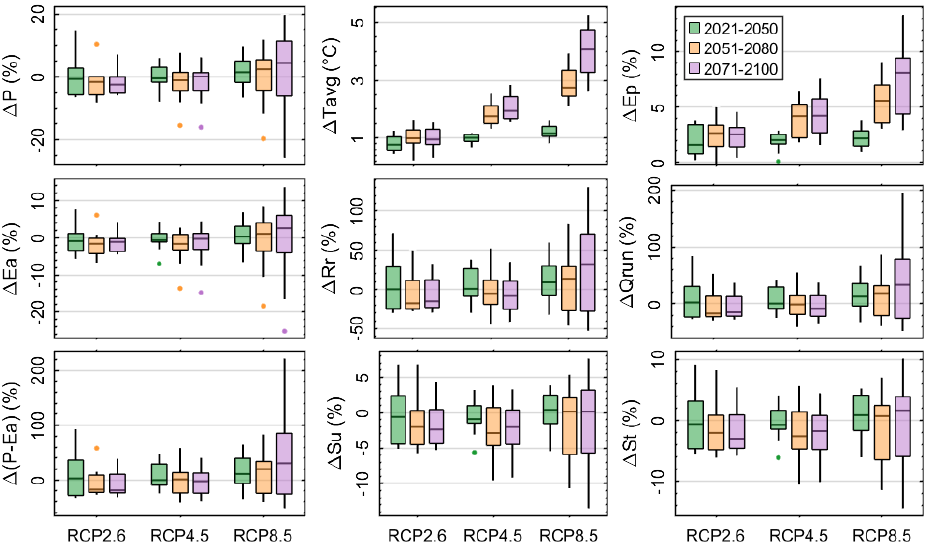
Figure 9. Annual changes in future hydroclimatic variables and water availability ( P − E a ) relative to the historical period for RCP2.6 (9 models), RCP4.5 (16 models), and RCP8.5 (18